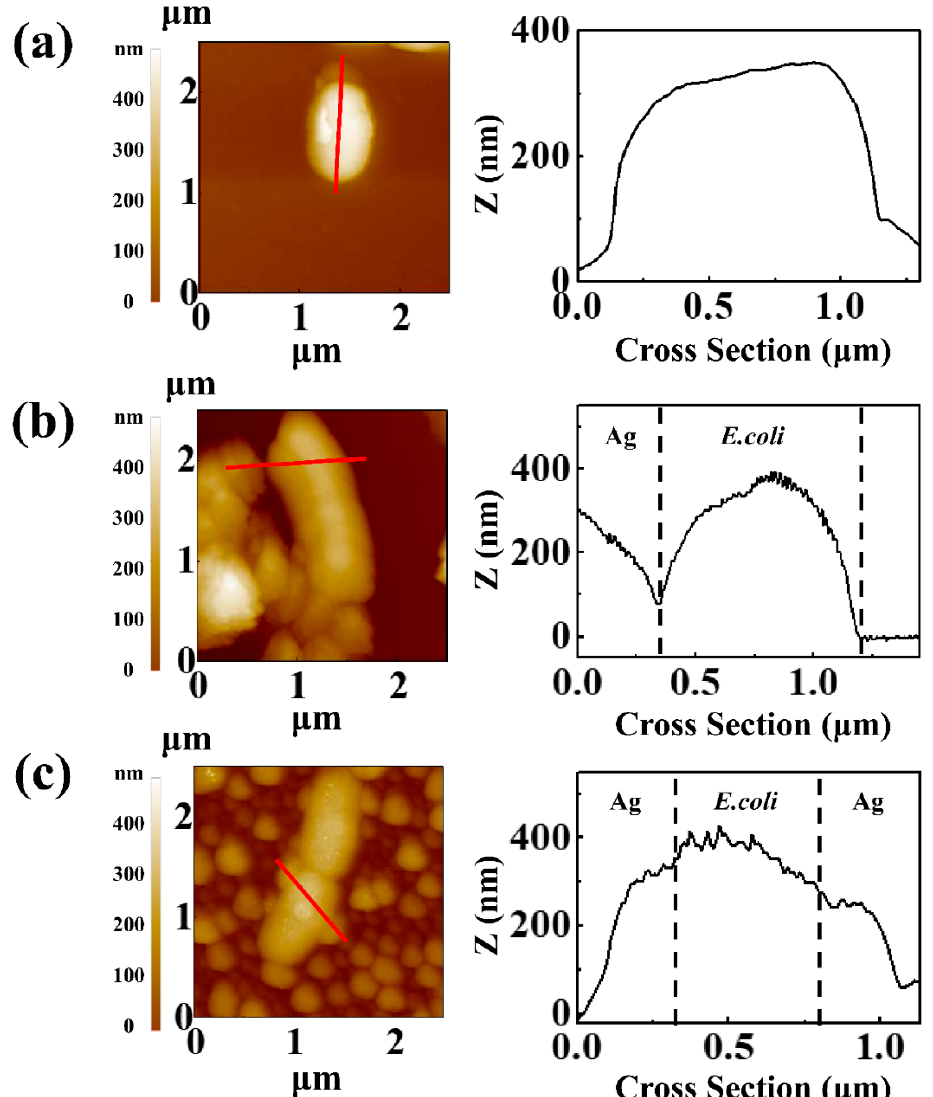
Figure 6. AFM topography ( left ) and line profile along red line ( right ) for E. coli on ( a ) bare Si, ( b ) AgNP@Si, and ( c ) Ag-hc@Si.